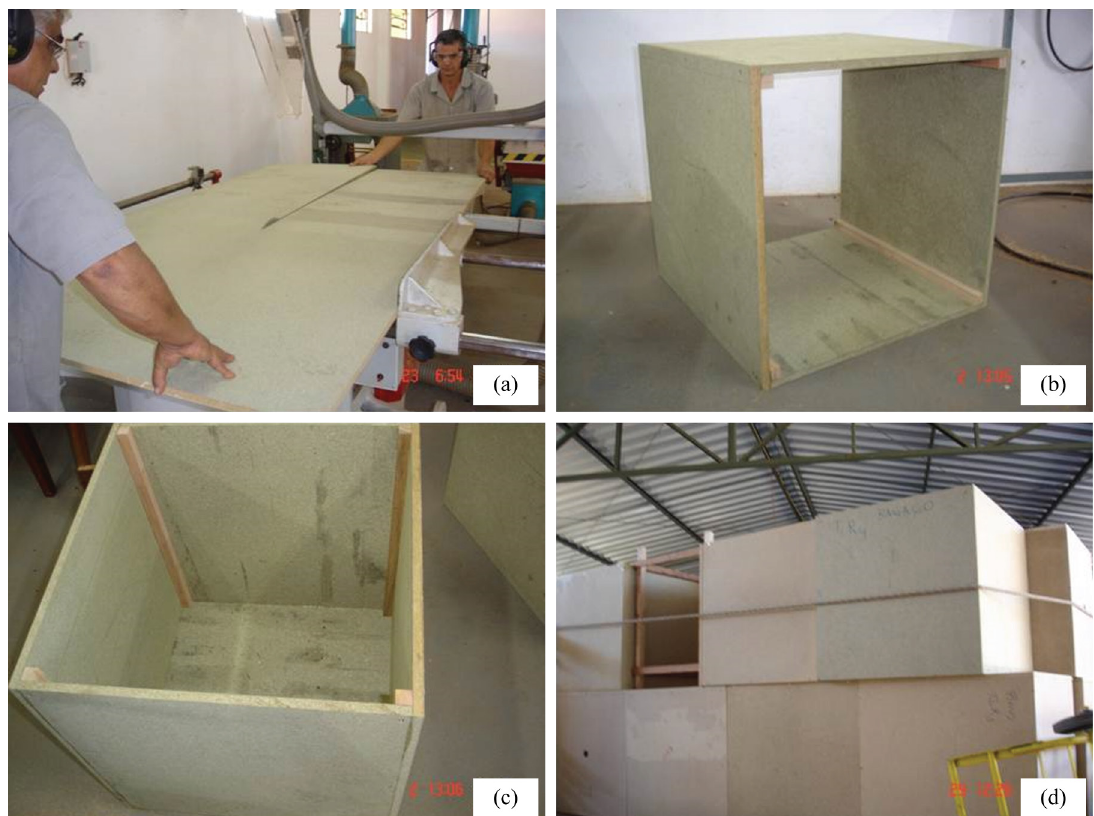
Figure 1. Development of modules; (a) Acquired panel; (b) and (c) Module assembly; (d) Set of modules